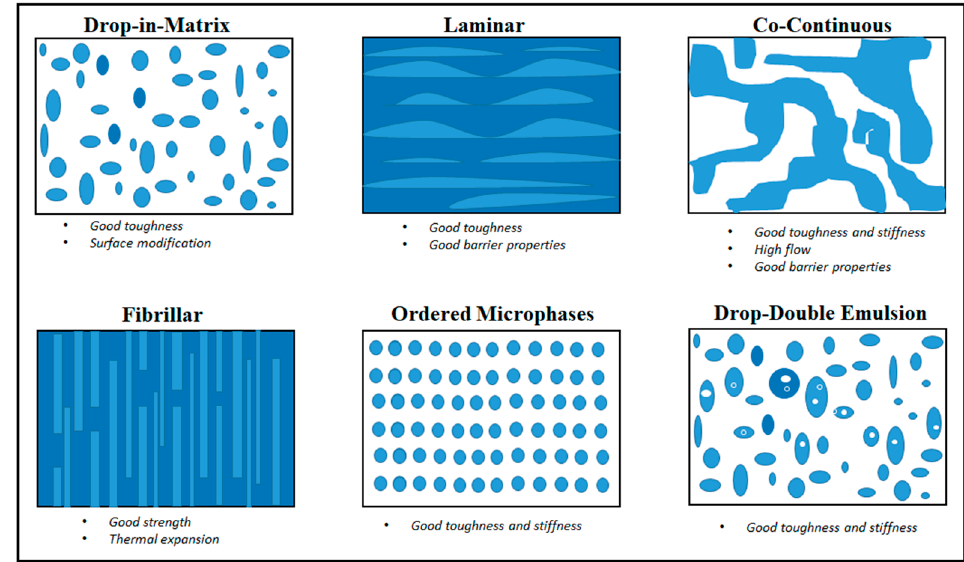
Figure 9. Types of morphology in immiscible polymer blends.